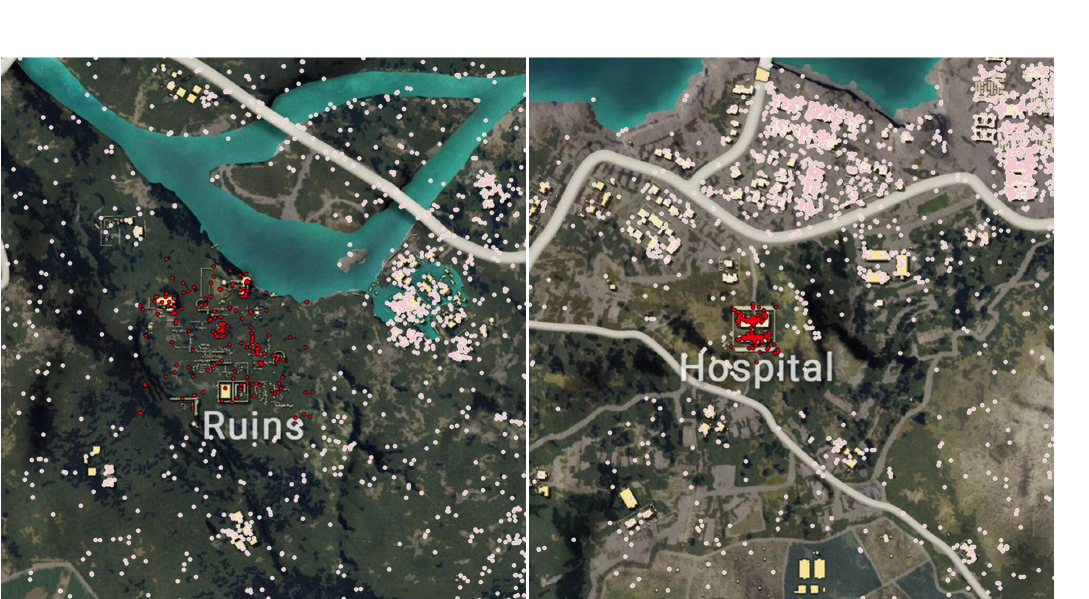
Figure 4. The locations ‘Ruins’ and ‘Hospital’ demonstrate how CPTED can be applied using a single component, natural surveillance. The Ruins offers players a more disperse and open area, while the hospital provides a fence and building. The two locations have similar death counts. Ruins consists of 156 observations, and the Hospital has a total of 167 observations. While the two areas share similar observations of the victim’s death, the two locations offer different forms of